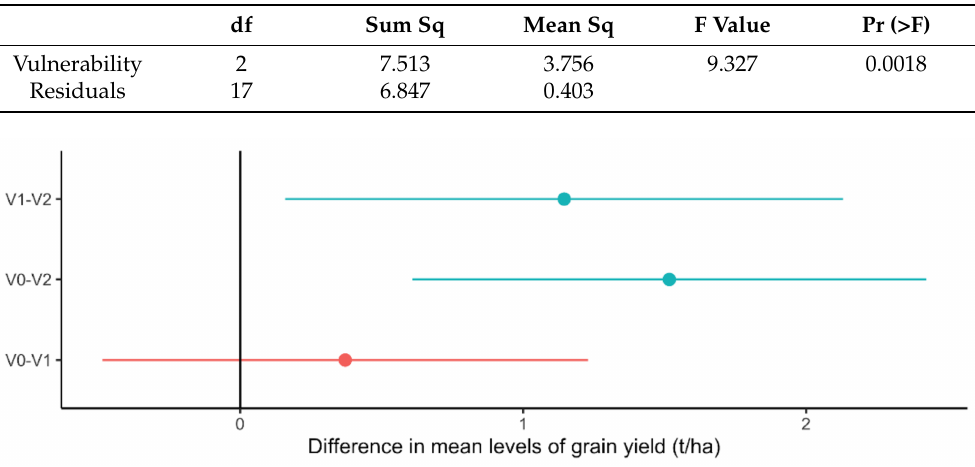
Figure 7. Model 3, grain yield optimal model, 95% family-wise confidence level pairwise difference among mean levels of vulnerability. Cyan-colored data are significant at p < 0.001